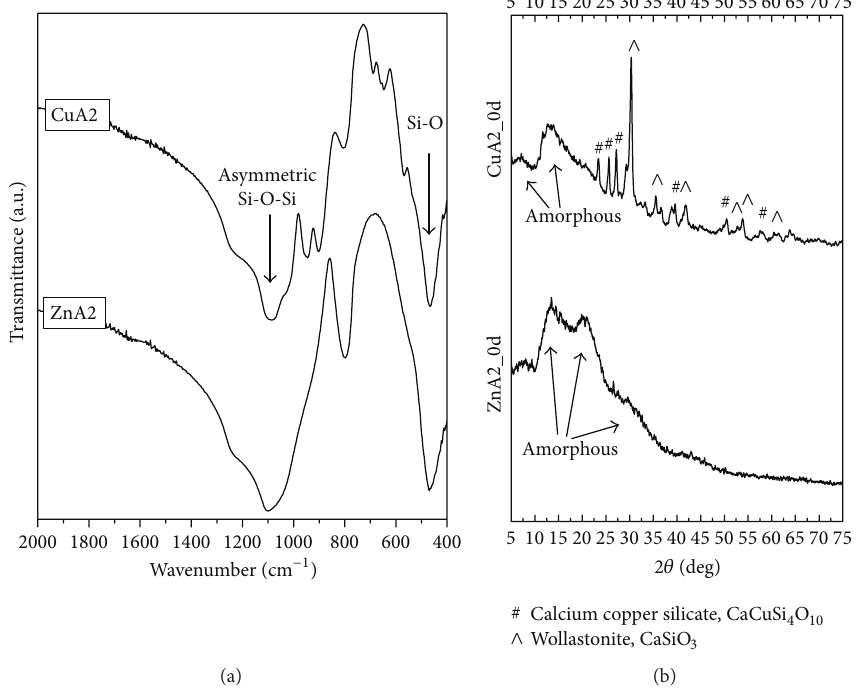
Figure 3: (a) FTIR spectra and (b) XRD patterns of ZnA2 and CuA2 glass-ceramic scaffolds.